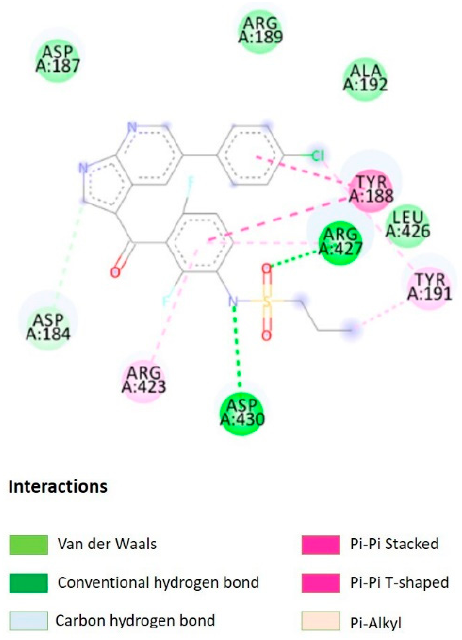
Figure 2. Binding interaction of vemurafenib with IFI144L.